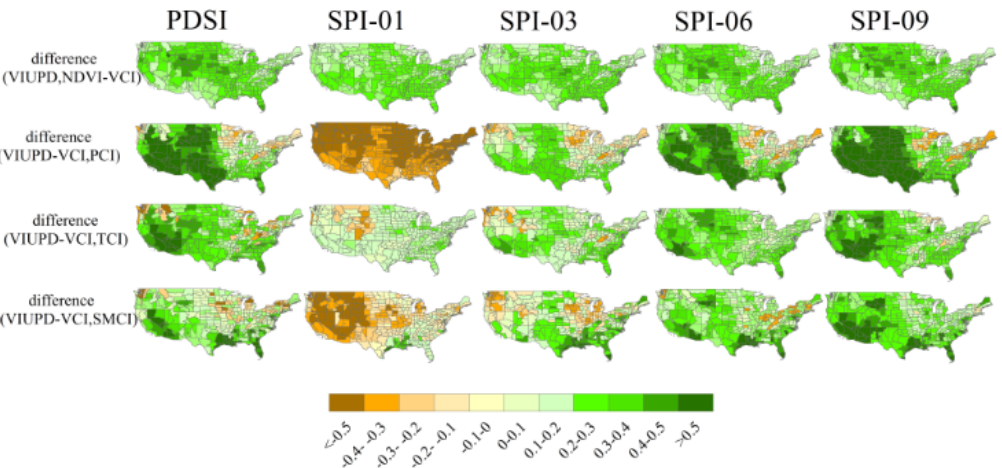
Figure 7. The mean temperature and mean NDVI of each CD in the growing season from 2002 to 2011. The sub-figure ( a ) is the mean temperature and sub-figure ( b ) is the mean NDVI of each CD in the growing season from 2002 to 2011. In the sub-figure ( a ), the red color stands for the warmer temperature and the blue color stands for the cooler temperature; in the sub-figure ( b ), red color stands for the lower NDVI and green color stands for the higher NDVI.